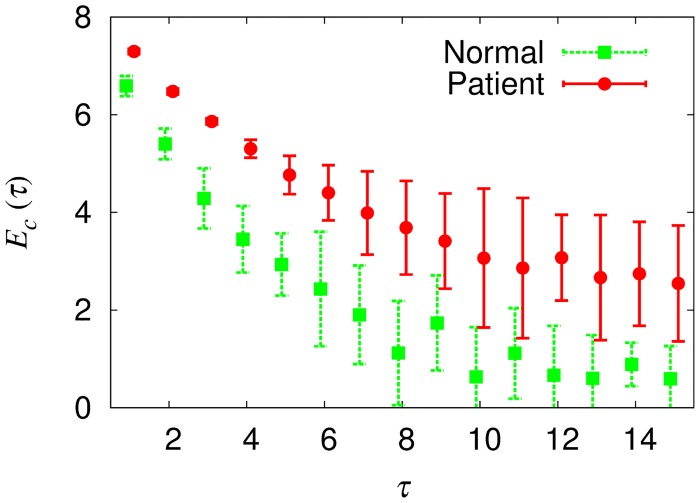
Clustering coefficient entropy E
c inferred from multivariate data versus scale factor τ.The multivariate time series consists of Z-components of four isolated time series. The average value of the normal group (green) is smaller than that of the patient group (red). The difference is statistically significant (student’s t-test, p < 0.05) in every examined scales (τ ≤ 15). Below τ = 5, every normal subject has a smaller value of E
c than every patient, as manifested by the small error bars.